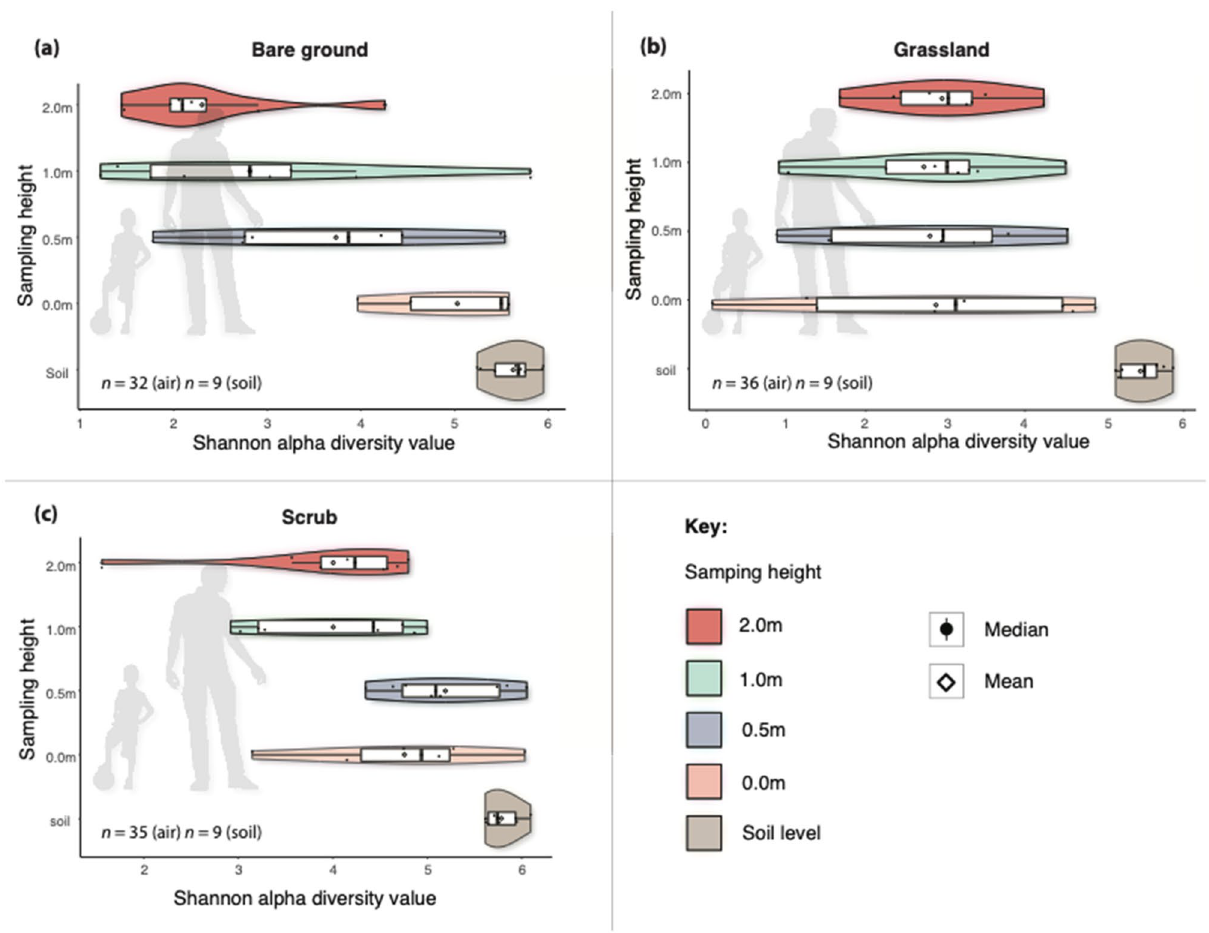
Figure 3. Box/violin plots of Shannon alpha diversity scores for each sampling height including soil and for each habitat: ( a ) bare ground; ( b ) grassland; and ( c ) scrub. Plots also display mean values, interquartile range and kernel density estimation, and silhouettes of humans for